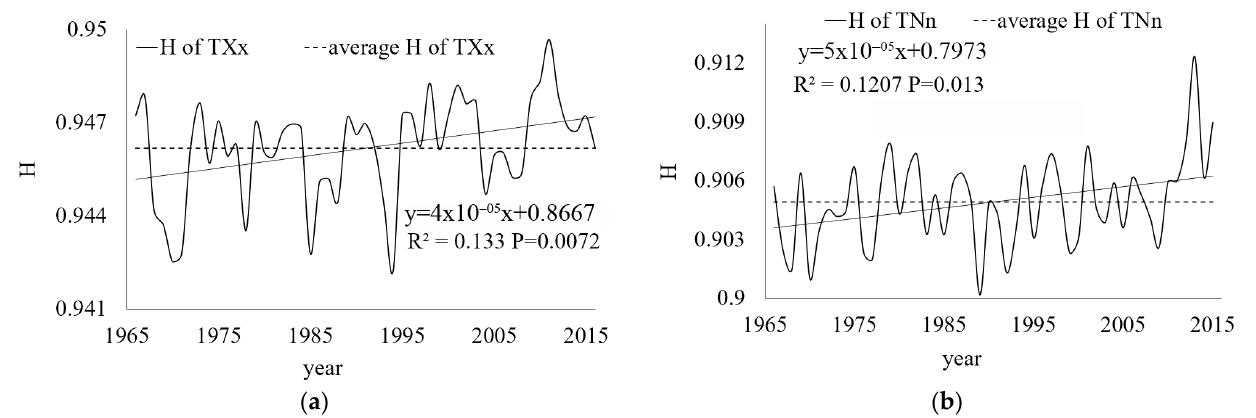
Figure 9. Temporal changes in H values of TXx and TNn in China, 1966–2015. ( a ) TXx. ( b ) TNn. Spatially, regions with relatively instable TXx include Inner Mongolia, Henan, Anhui, Hubei, Chongqing, Hunan, Jiangxi, and Fujian. In general, the instability of TXx was stronger in the middle and lower reaches of the Yangtze River than in other regions of China. TNn shows stronger instability in the Yangtze River headwaters region, the Yellow River and Lancang River regions, and parts of Tibet (Figure 10).